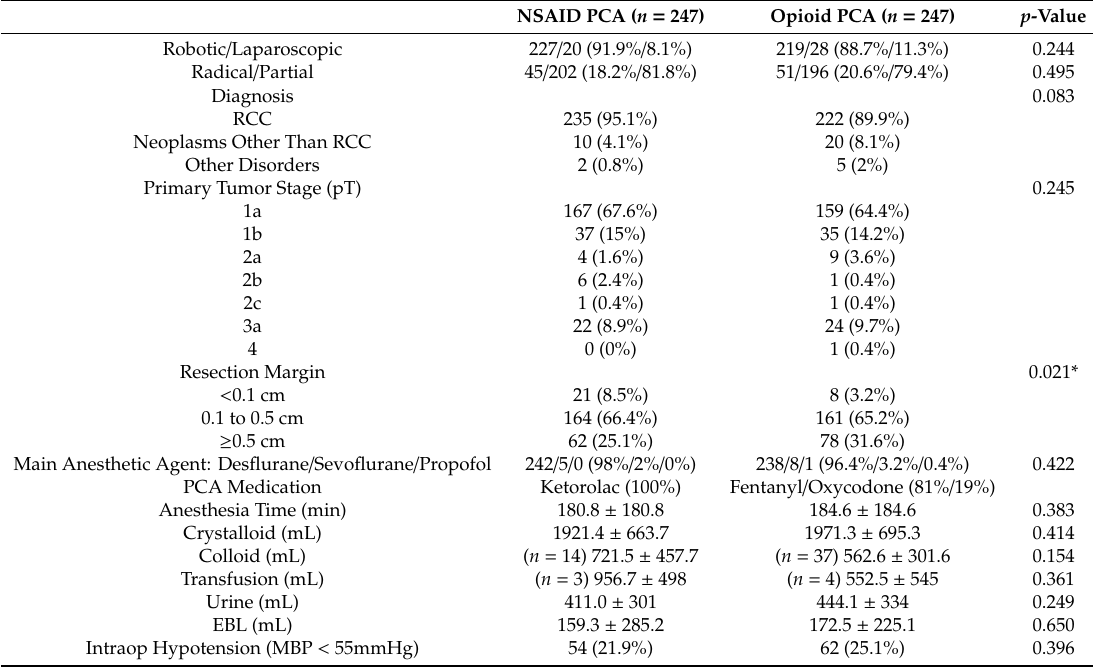
Table 2. Anesthetic and surgical